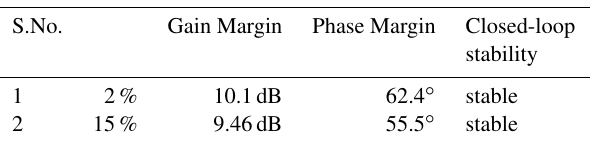
Table 8. Robustness analysis of inlet temperature for 2% and 15% changes in T in .